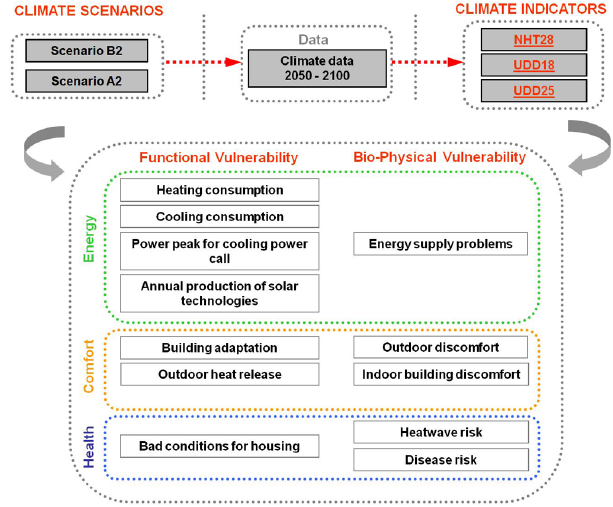
Fig. 9. Vulnerability models and impacts on energy, comfort and